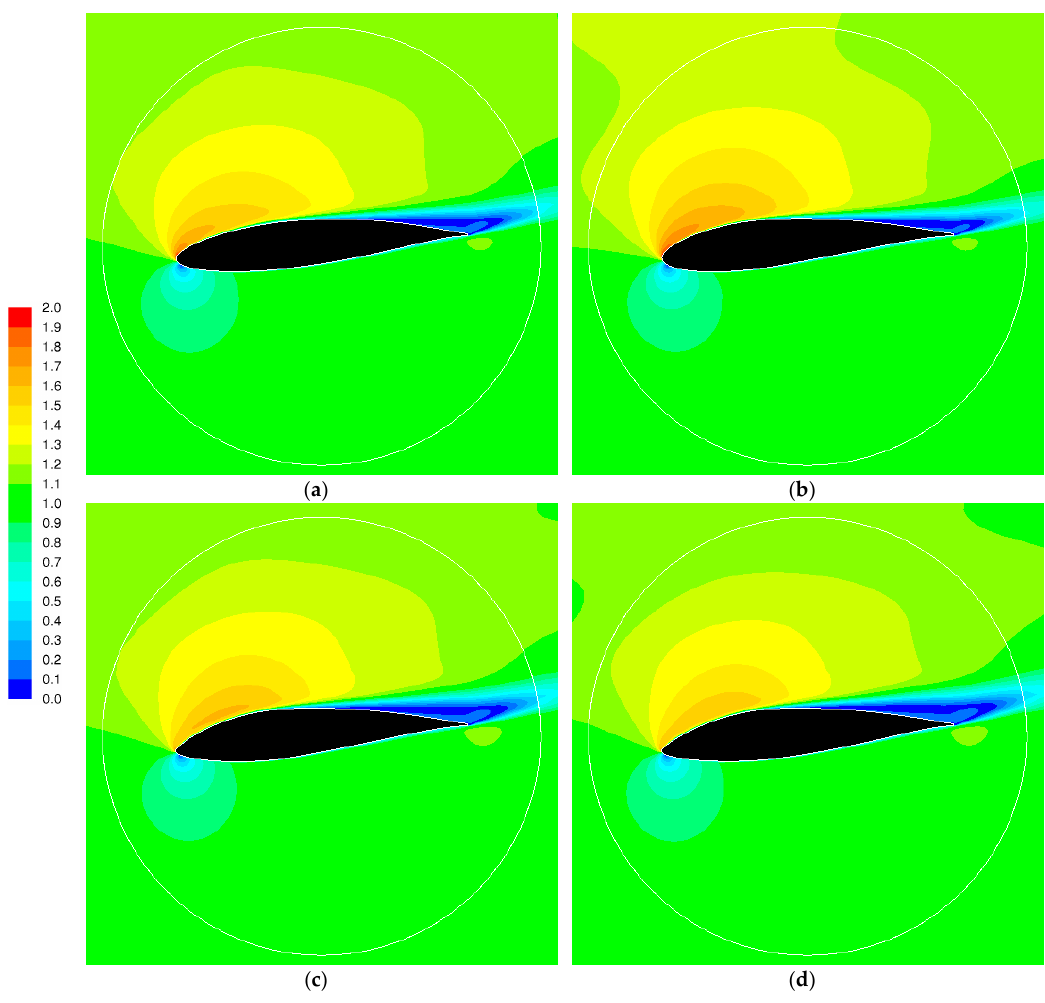
Figure 12. Predicted distribution of dimensionless velocity magnitude around the airfoil for Re = 100,000, BA = 5°, FA = 15° (AoA = 10°), for L/C = 3, ( a ) Original profile; ( b ) Point 1; ( c ) Point 2; ( d ) Point 3 (Figure 9).